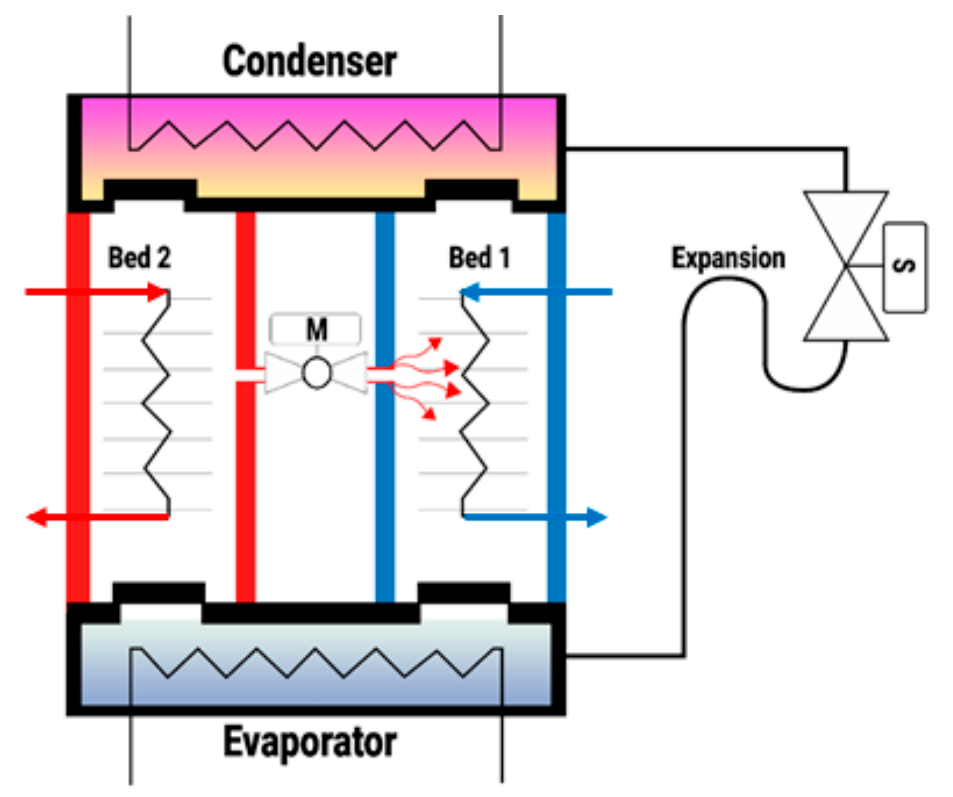
Figure 1. Concept of mass